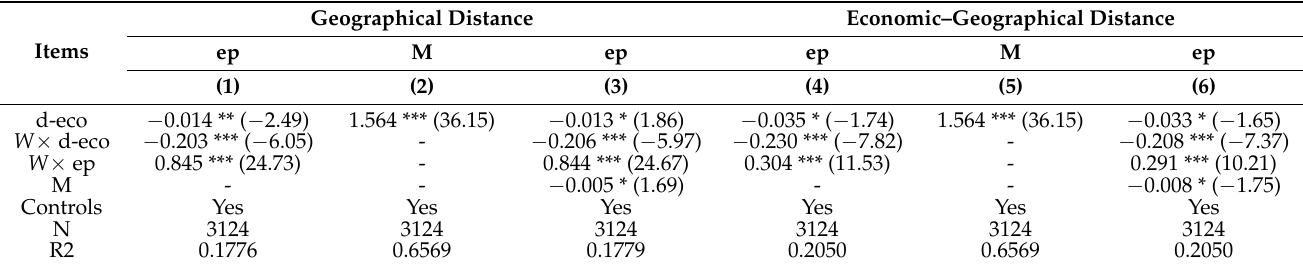
Table 8. Mechanism test of innovative development effect.